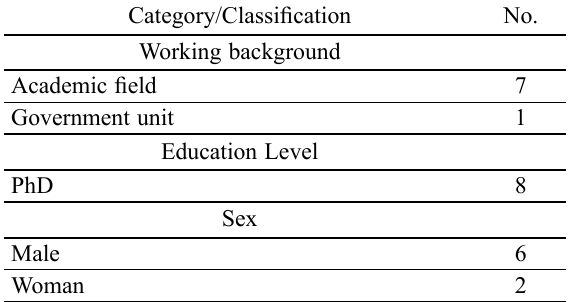
Table 6. Background information of experts participated in ANP and VIKOR